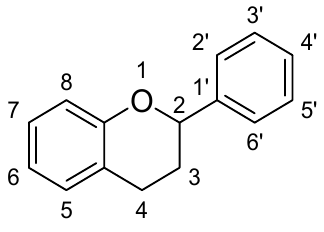
Figure 1. Skeleton of Flavonoids.